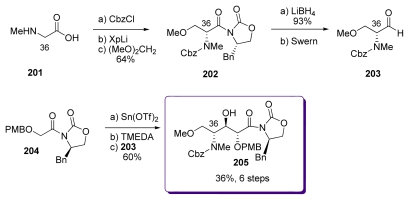
Preparation of 205.